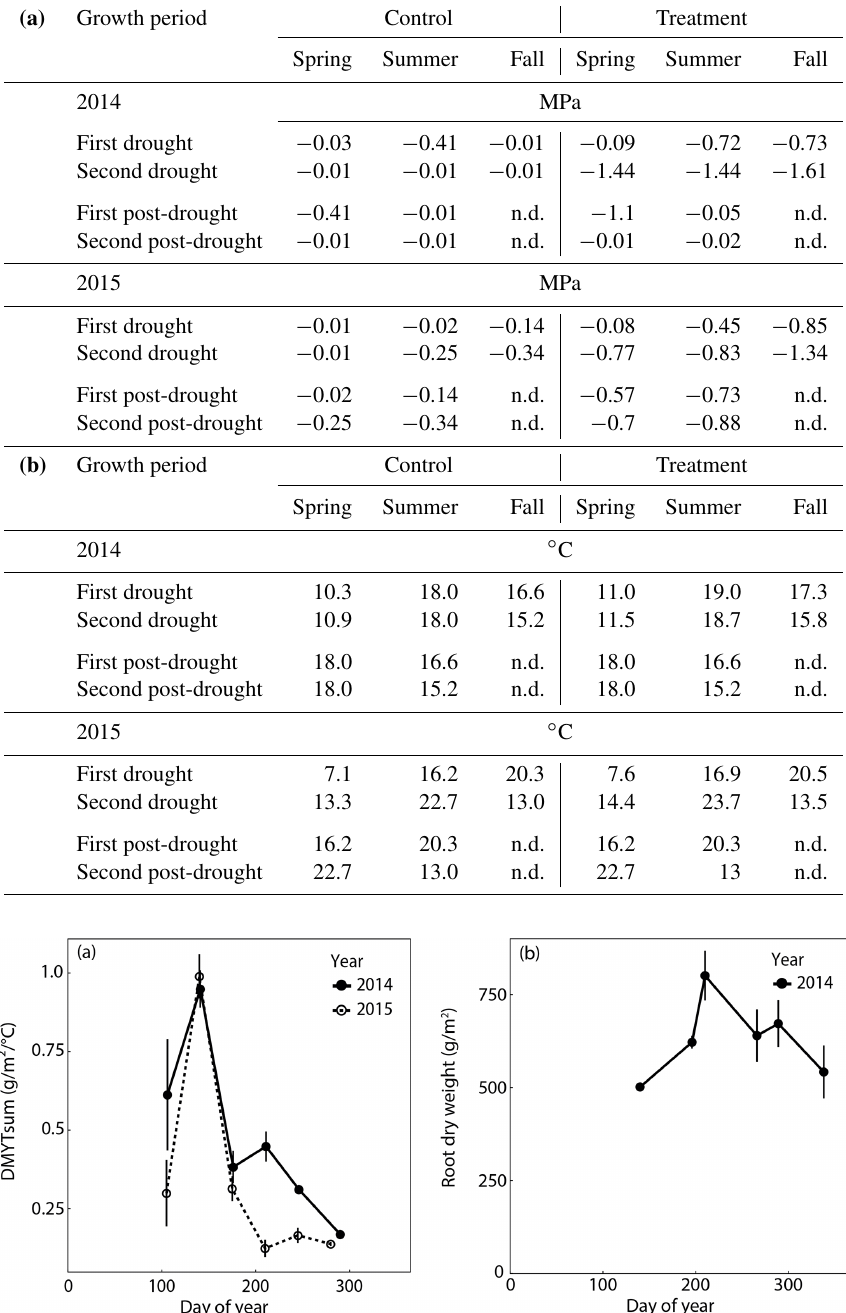
Figure 3. (a) Temperature-weighted growth rates (DMYT sum ) of aboveground biomass of rain-fed control plots in 2014 and 2015. Values displayed are the means across the six investigated grass species and cultivars ( n = 6; ± SE). (b) Belowground biomass of rain-fed control plots in 2014. Values displayed are the means across the four grasses, namely L. perenne early (LPe) and late (LPl) flowering and D. glomerata early (DGe) and late (DGl) flowering ( n = 4; ±